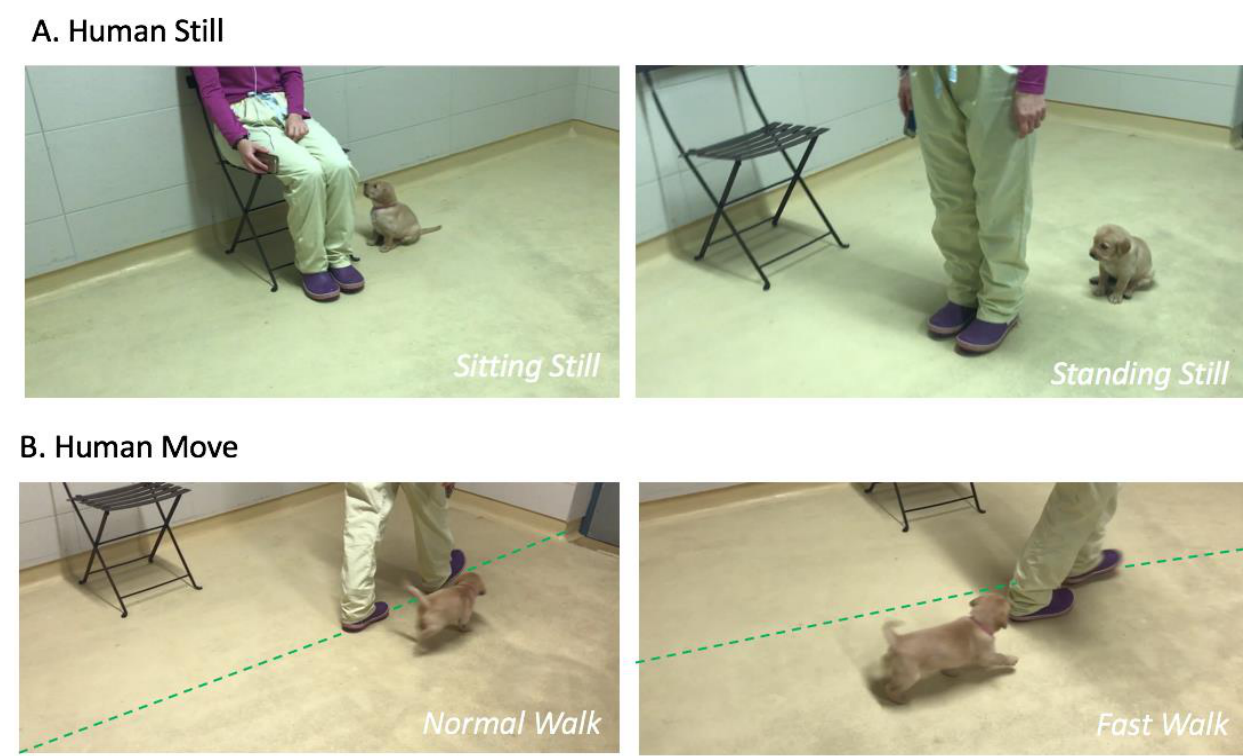
Figure 2. Testing conditions. ( A ): Human Still condition. The experimenter is staying still at the predefined locations. ( B ): Human Move condition. The experimenter is walking along the predefined line (added in green only for the photo).